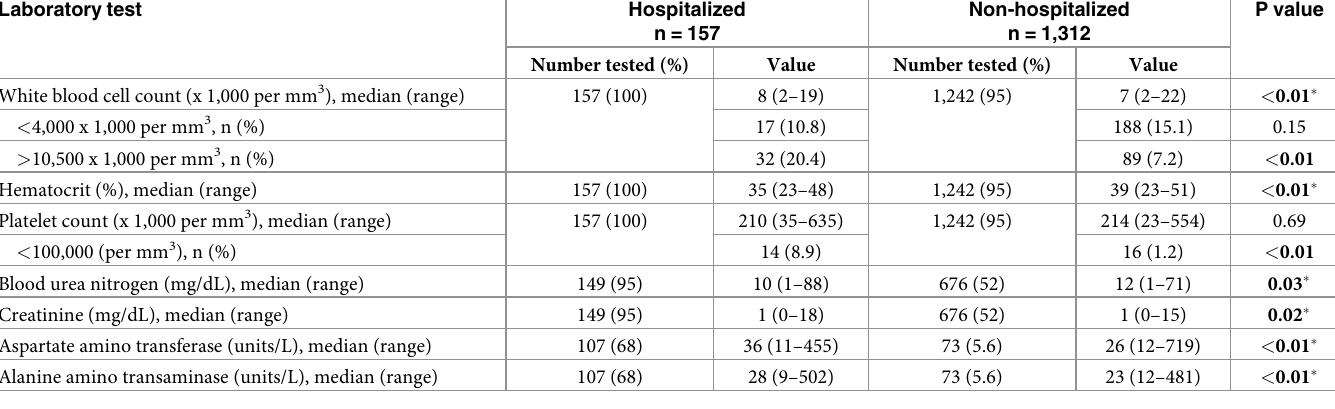
Table 4. Results of laboratory analysis of specimen collected in the emergency department from hospitalized and non-hospitalized, chikungunya virus-infected patients enrolled in the sentinel enhanced dengue surveillance system, May–December, 2014 (N =